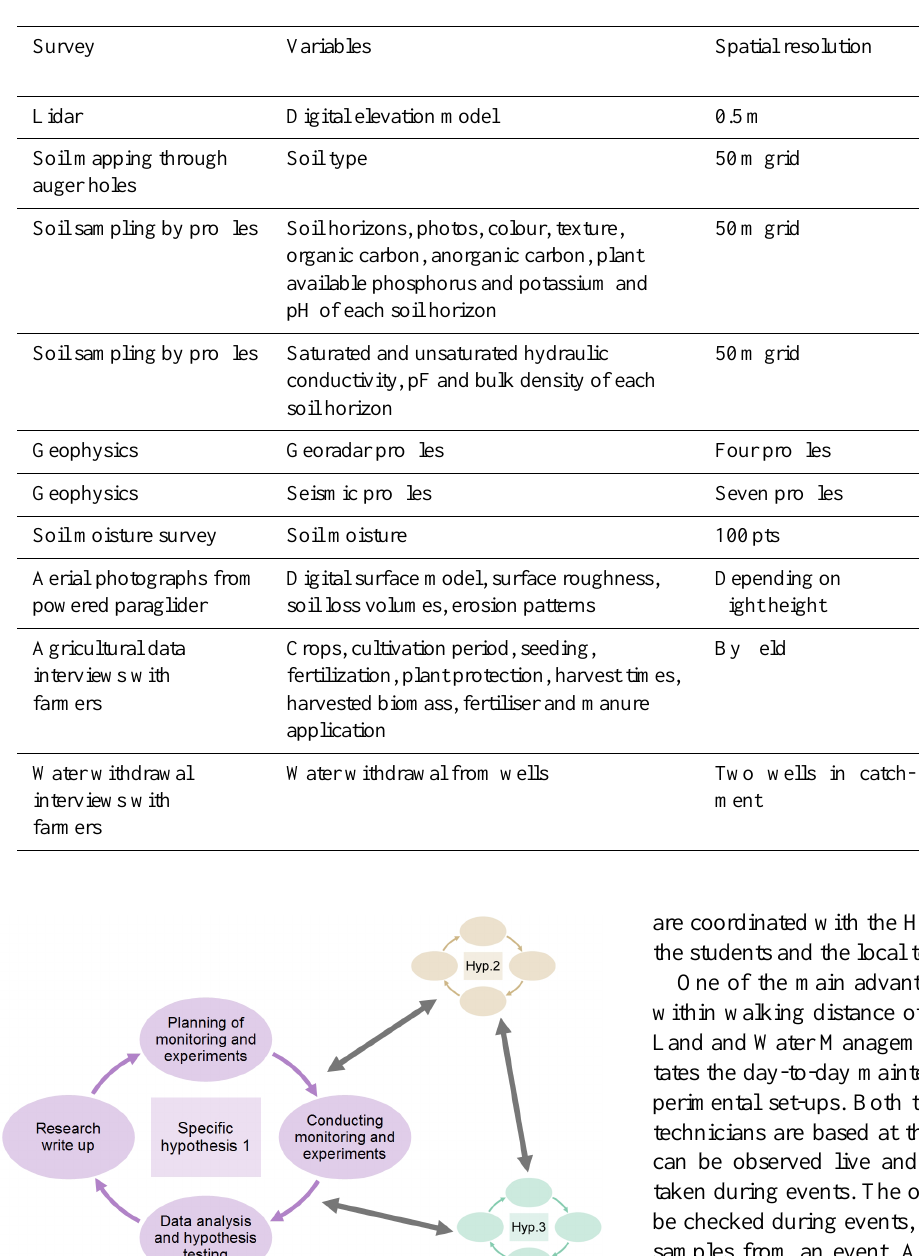
Table 2. Spatial surveys of catchment characteristics. For details see Appendix B.